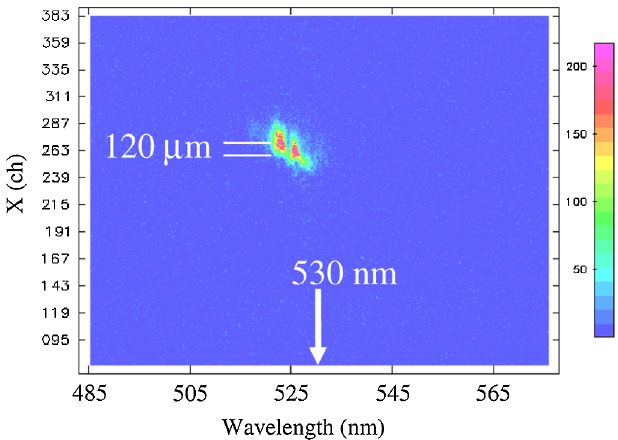
FIG. 1. (Color) An example of the imaging spectrometer data after undulator 6 showing the COTR x - (cid:2) dependence at (cid:1) 530 nm first reported at FEL02